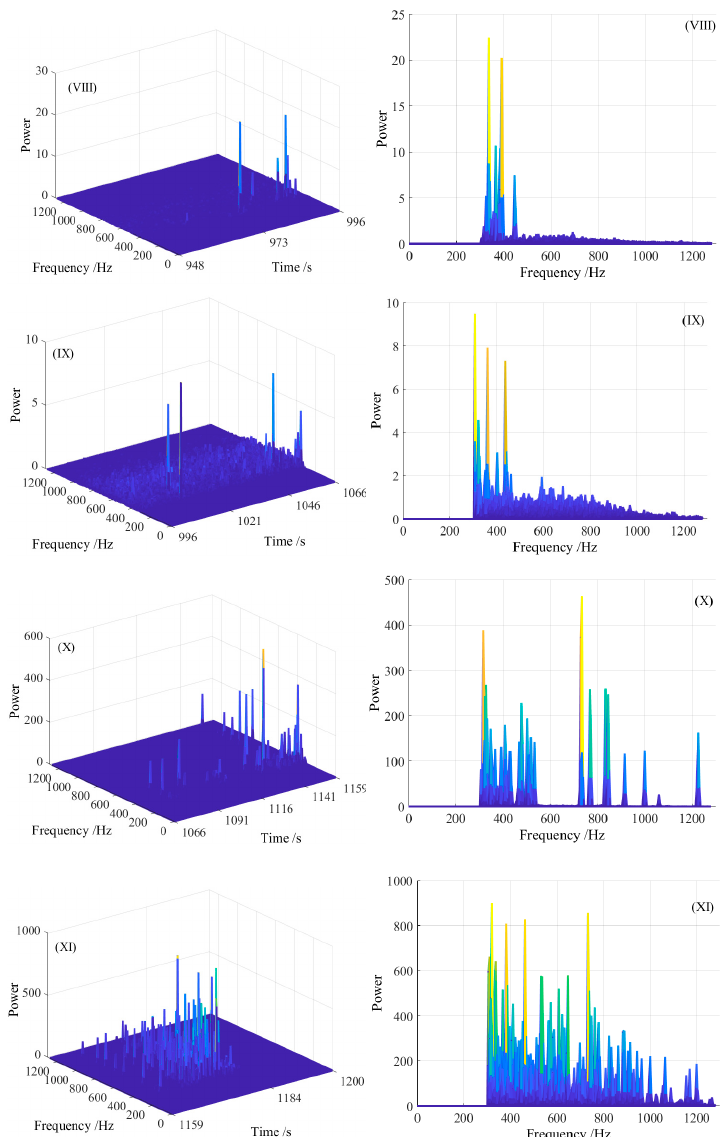
Figure 12. Hilbert power spectrum of the high-frequency component of MS at loading stages I–XI in Exp. Y1. Note: the left part is the Hilbert power spectrum, and the right part is the power-frequency diagram. The power in the Figure 12 is dimensionless, which represents the possibility of the signal in a specific time and frequency.